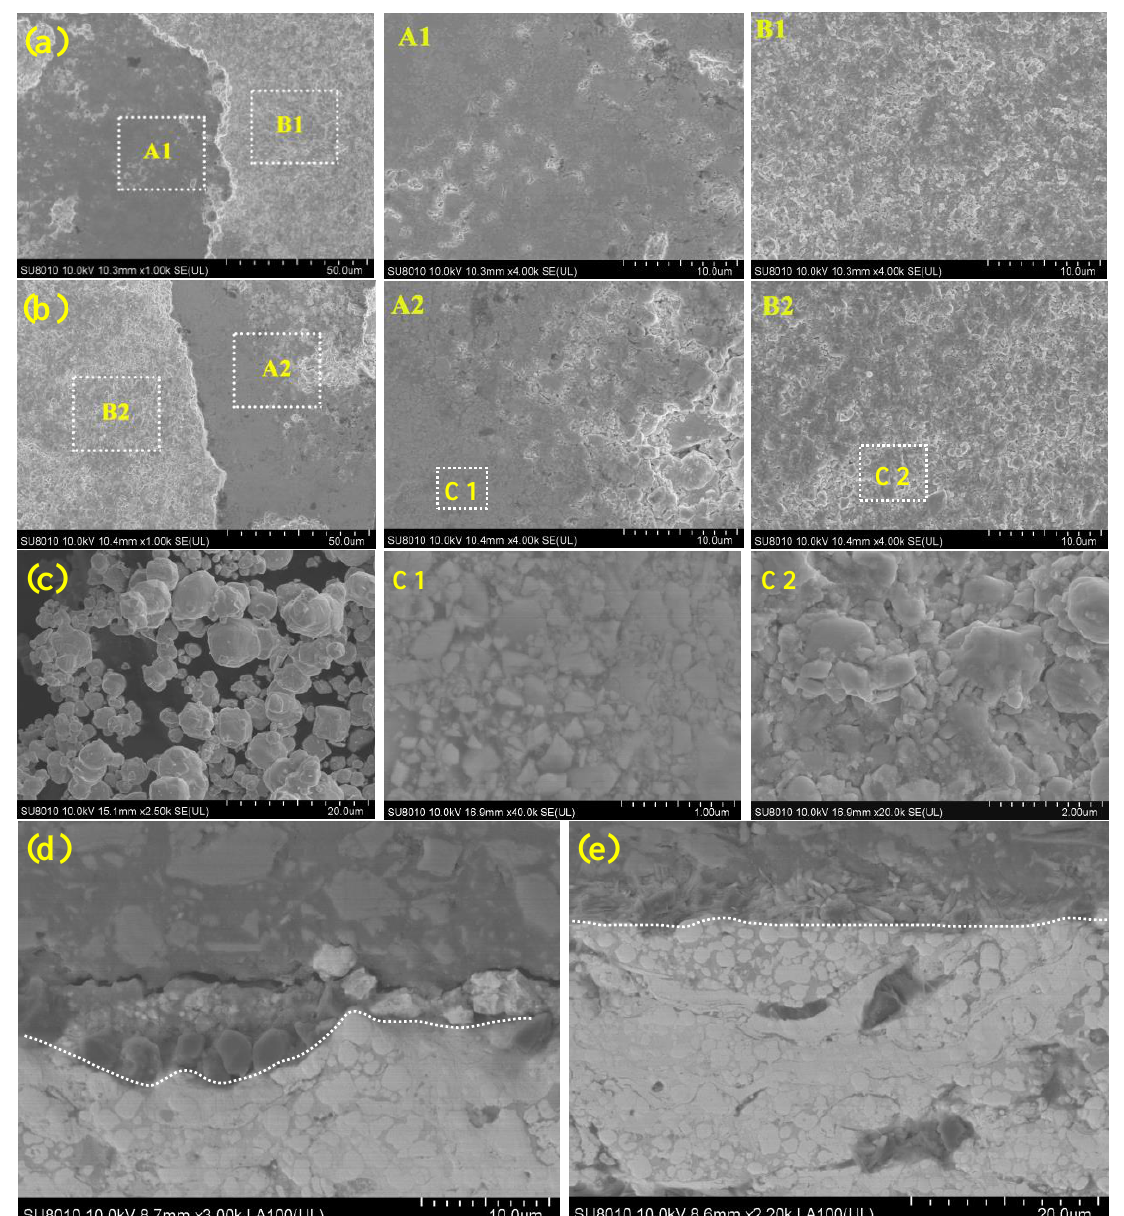
Figure 11. ( a ) Morphology of coating wear scar under 1.5 μm : ( A1 ) tribo – layer area, ( B1 ) non – tribo – layer area. ( b ) Morphology of coating wear scar under 4 μm: ( A2 ) tribo – layer area, ( B2 ) non – tribo – layer area. ( c ) Morphology of 4 μm particles; ( C1 ) enlarged view of tribo – layer area; ( C2 ) enlarged view of non – tribo – layer area. ( d ) The cross – section of coating after rubbing under small − sized particles condition; ( e ) the cross − section of unworn coating.